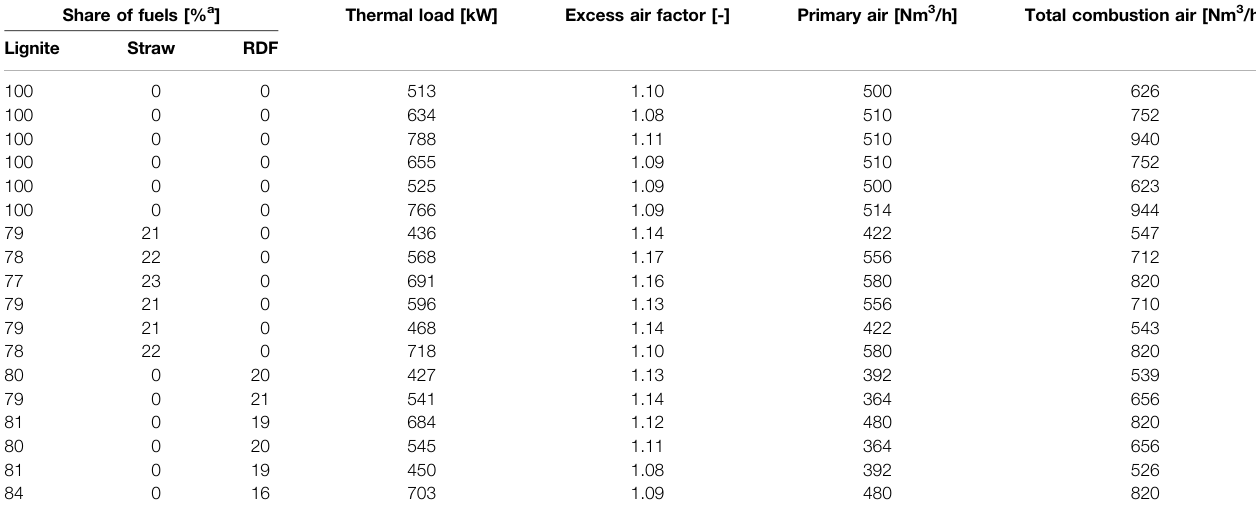
TABLE 4 | Boundary conditions of dynamic test series with lignite, straw, and RDF. Share of fuels [% a ]